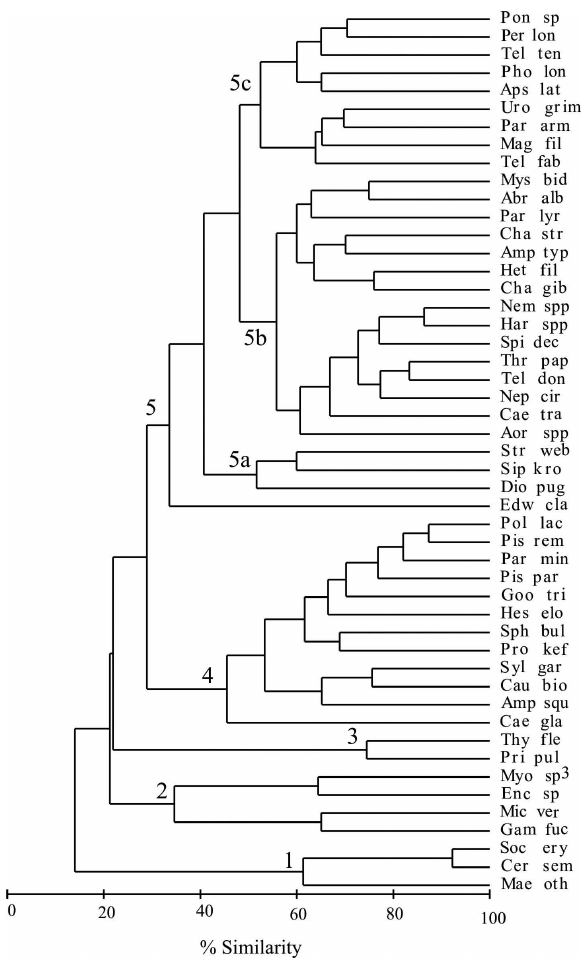
Fig . 3. – Dendrogram based on cluster analysis showing the classifi- cation of species with a numerical dominance ≥ 4% at any given site. Species codes are given in Table 3, except: Ampelisca typica : Amp typ; Amphipholis squamata : Amp squ; Aoridae spp: Aor spp; Cae- cum glabrum : Cae gla; Ceradocus semiserratus : Cer sem; Edwarsia claparedii : Edw cla; Enchytraeida sp.: Enc sp; Maera othonis : Mae oth; Magelona filiformis : Mag fil; Microdeutopus versiculatus : Mic ver; Socarnes erythrophthalmus : Soc ery; Sphaerosyllis bulbosa : Sph bul; Tellina donacina : Tel don; Tellina fabula : Tel fab; Tellina tenuis : Tel ten; Urothoe grimaldii : Uro